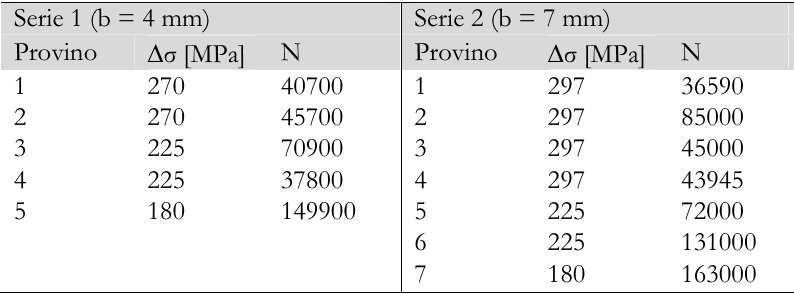
Tabella 1: Risultati delle prove di fatica.